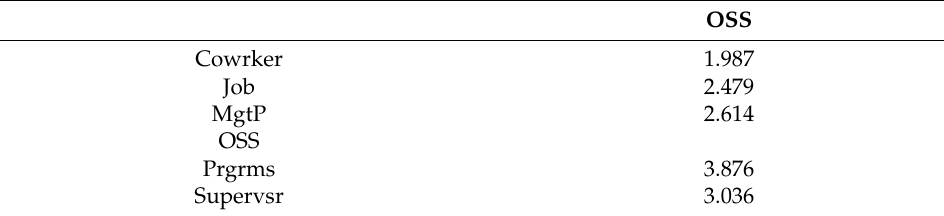
Table 6. Variance inflation factor (VIF).